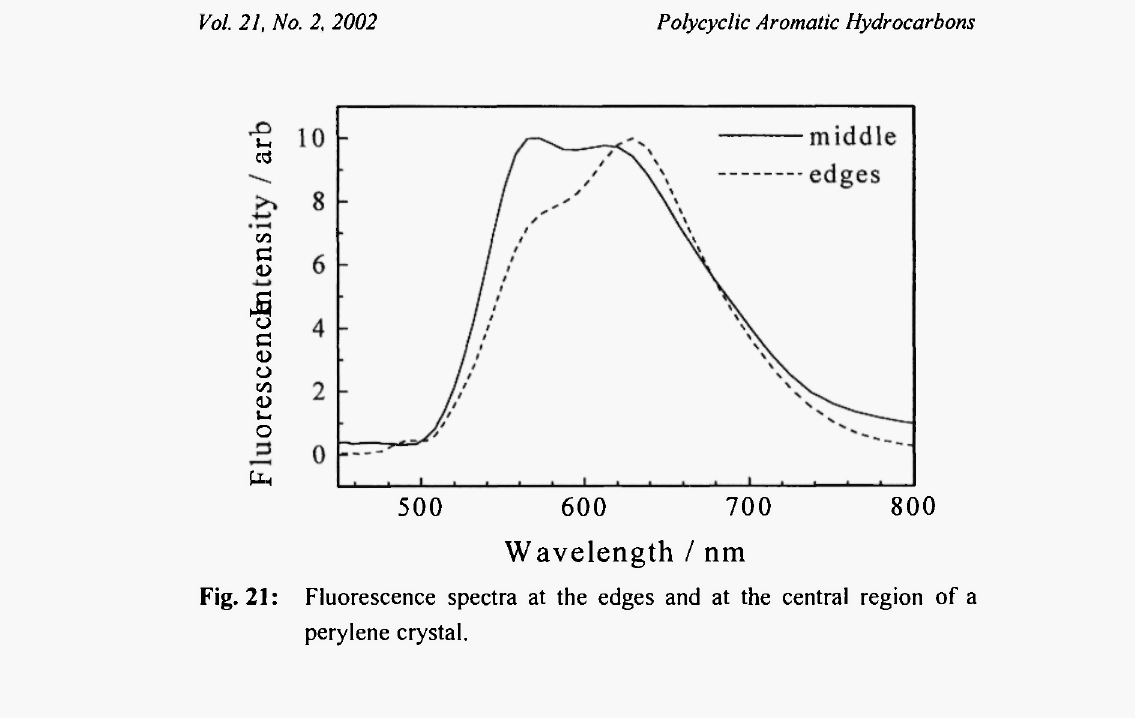
5 00 800 6 00 7 00 Wavelength / nm Fluorescence spectra at the edges and at the central region of a Fig. 21: perylene